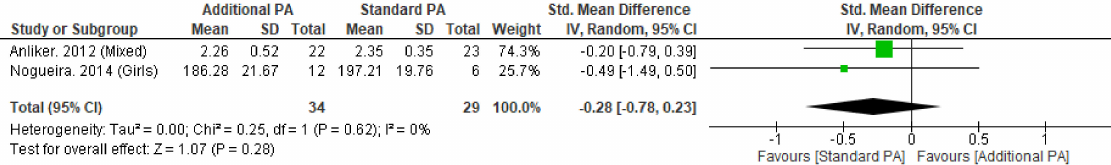
Figure A2. Effect of Additional Exercise Intervention on Volumetric Bone Mineral Content within the Tibia (4%) at Less than 12 Months Follow-up. Legend: PA = Physical Activity, Std = standardised, IV = inverse variance, SD- standard deviation, CI = confidence interval.